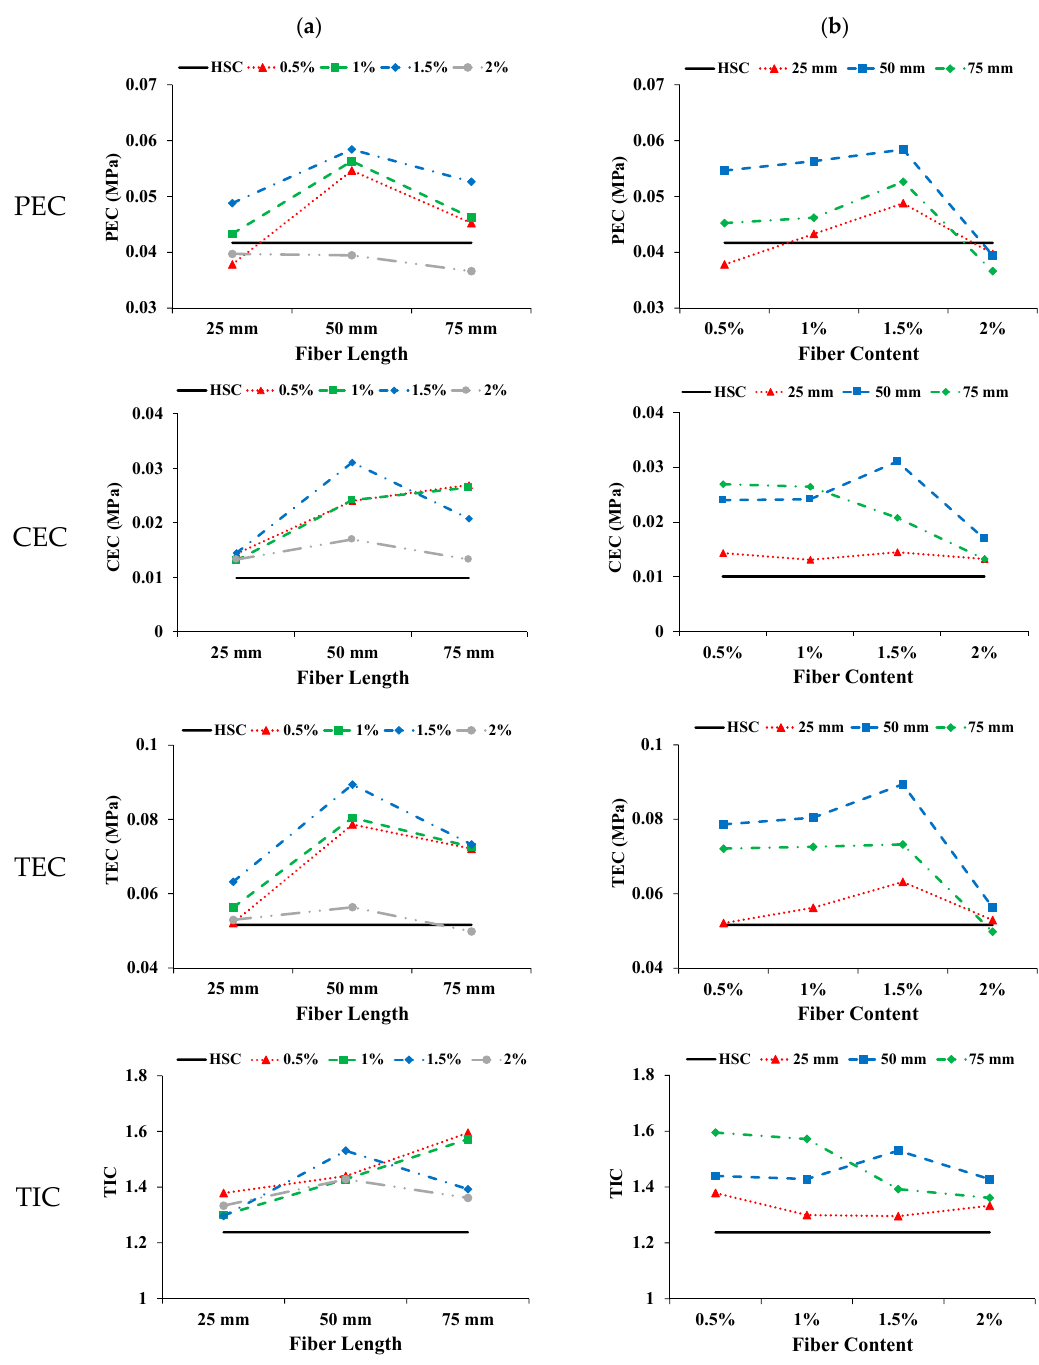
Figure 8. Influence of coconut fiber on PEC, CEC, TEC, and TIC: ( a ) Length; ( b ) Content .